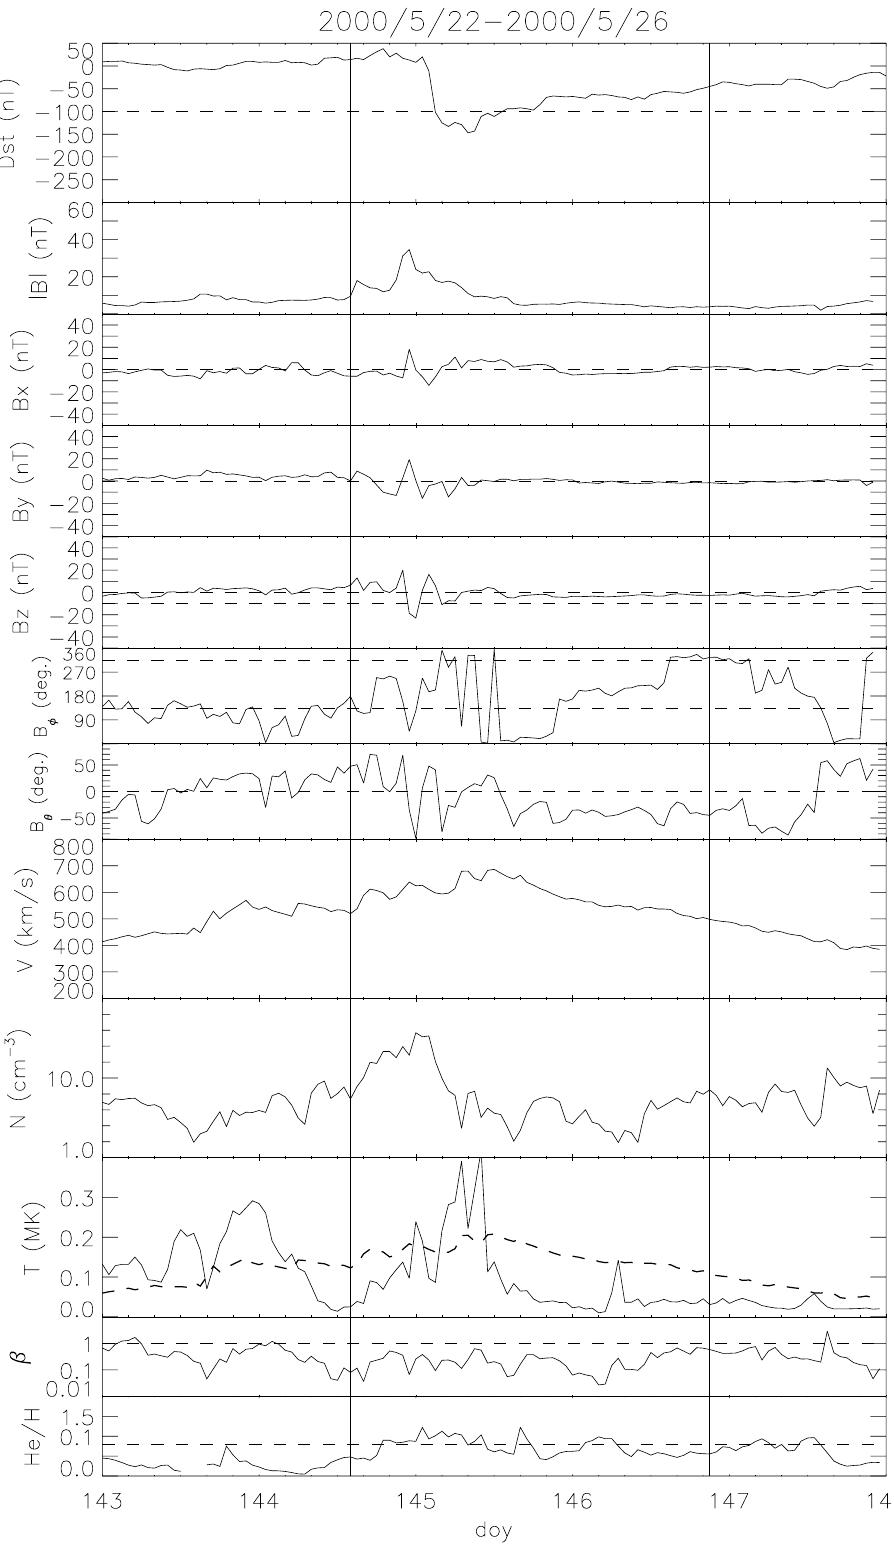
Fig. 8. D st index and solar wind parameters of storm no. 20. Two vertical solid lines show the duration of the geomagnetic